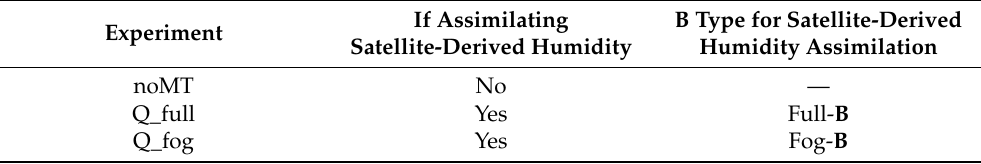
Table 1. List of